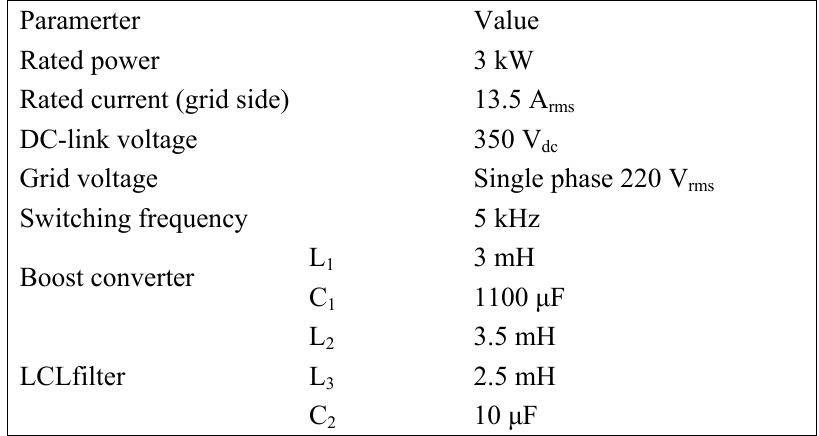
Table 2. Parameters of experimental setup.